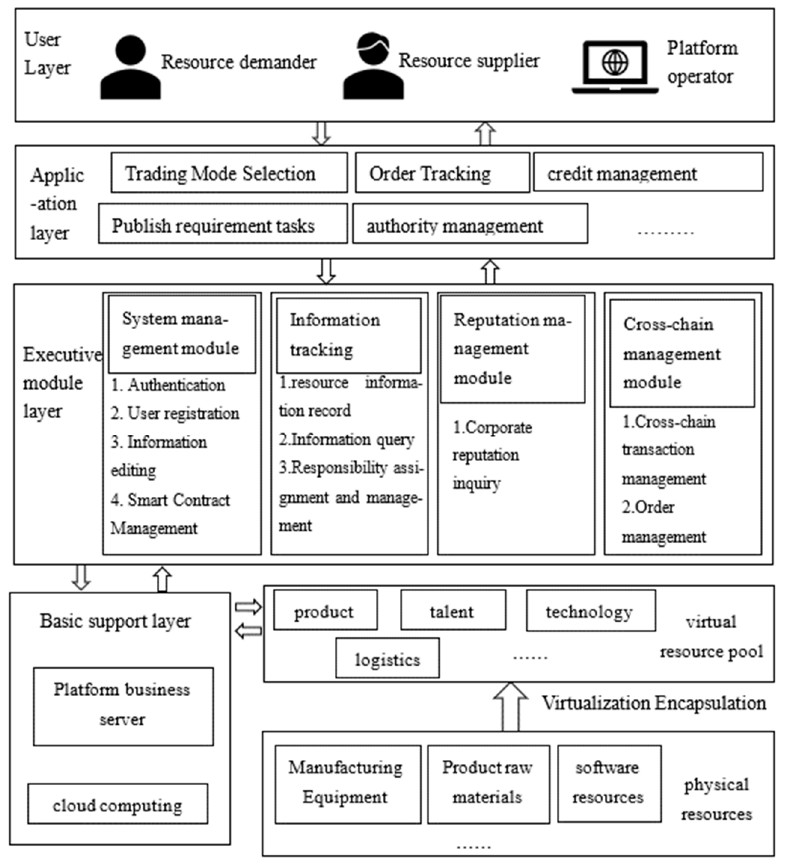
Figure 2. System architecture of the industrial interconnection supply and demand network re- source matching platform based on the Alliance blockchain. matching platform based on the Alliance